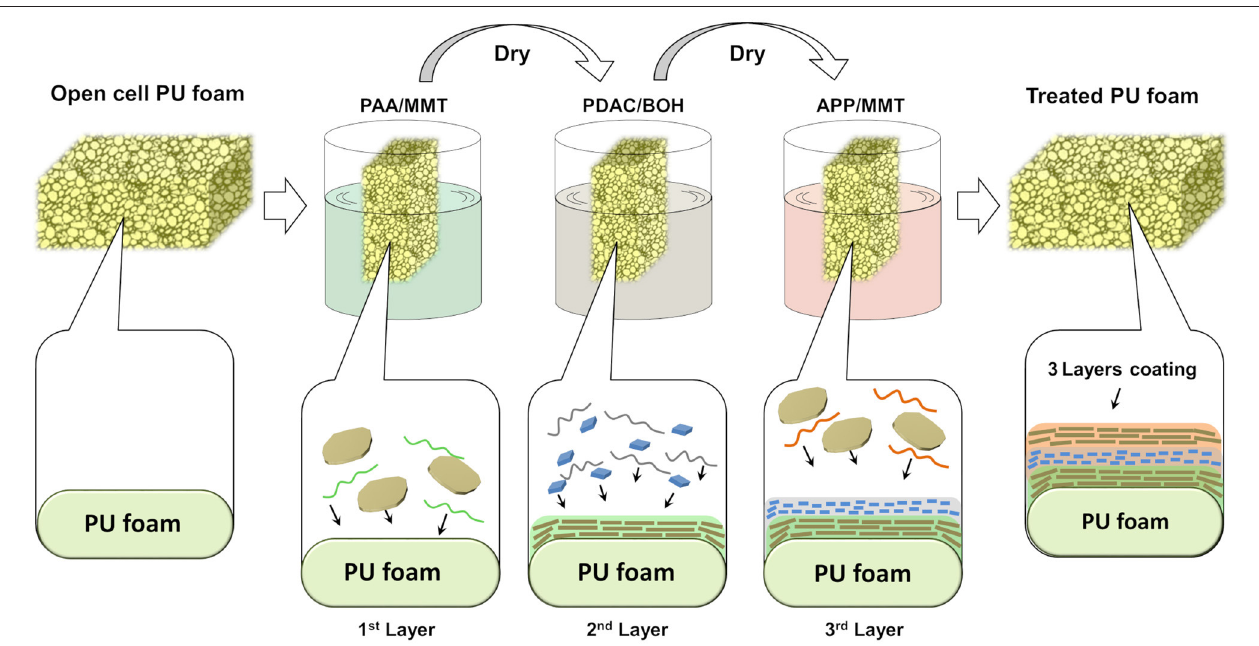
FIGURE 1 | Schematization of the coating procedure employed in this study. PU foams are dipped in three different baths following the order: polyacrylic acid/montmorillonite (PAA/MMT) suspension, poly(diallyldimethylammonium chloride)/boehmite (PDAC/BOH), and ammonium polyphosphate/montmorillonite (APP/MMT). This process deposits a three-layer